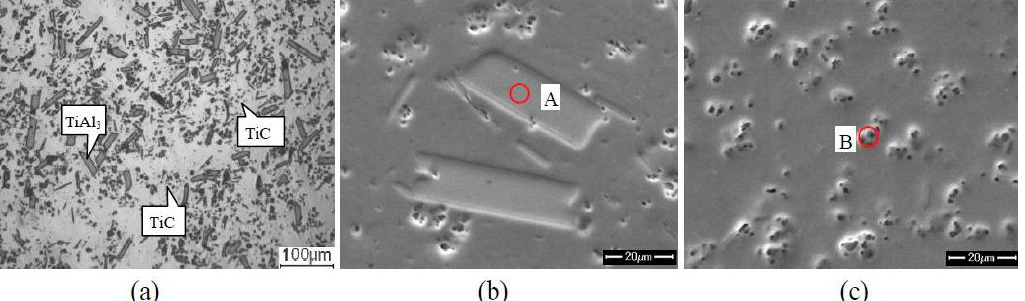
Figure 2. Microstructures of Al–5Ti–C alloy: ( a ) optical microscopy (OM) image; ( b ) scanning electron microscopy (SEM) image of TiAl